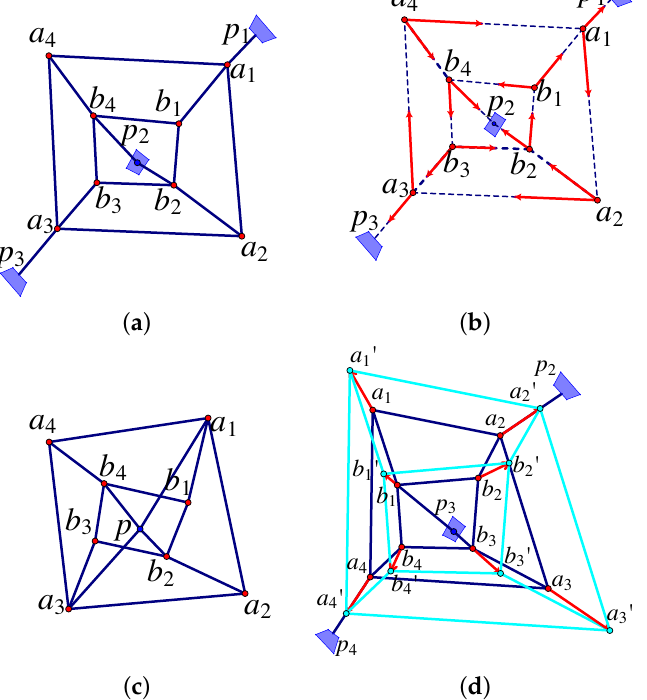
Figure 34. The pinned framework in ( a ) is Assur, with a 2-directed orientation ( b ). This orientation is strongly connected. With the pins identified, this forms a plane circuit ( c ). In a special position ( d ) there is a parallel drawing which geometrically corresponds to non-trivial velocities at all inner